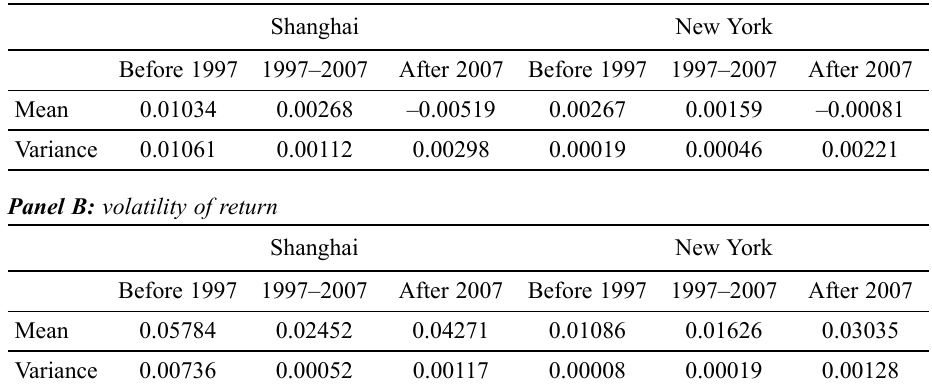
Table 4. Rate of return and volatility in three